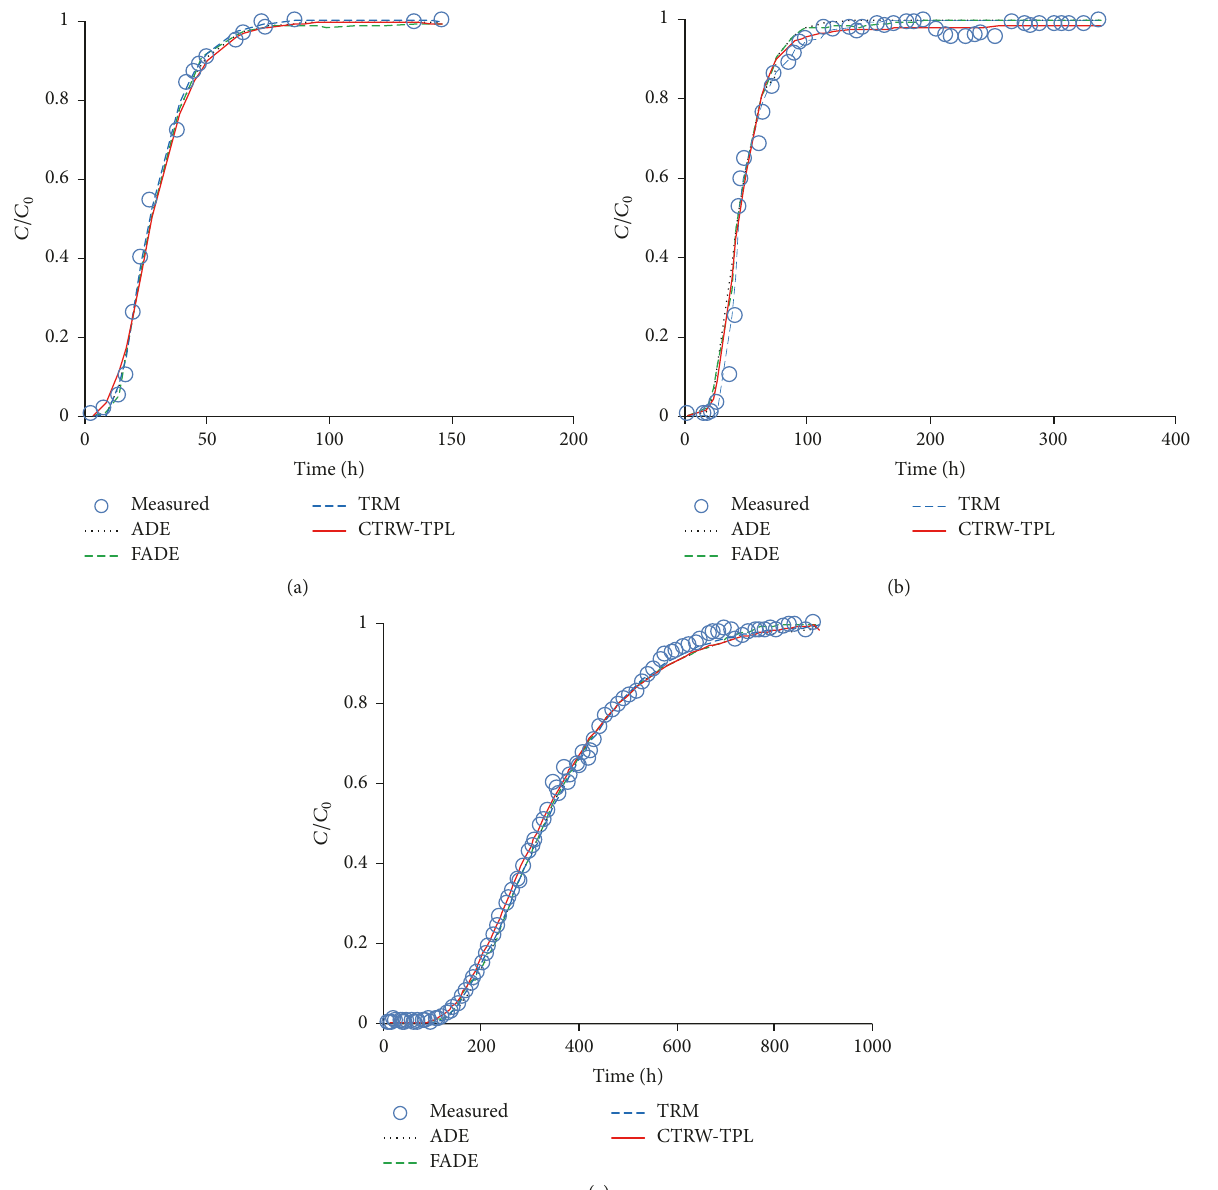
Figure 3: Three sets of measured breakthrough curves fitted with ADE, FADETRM, and CTRW (based on TPL), for the homogeneous, saturated, and smooth wall soil columns with the same inner diameter (14cm) but different column lengths: (a) 3cm; (b) 5cm; (c) 8 cm.